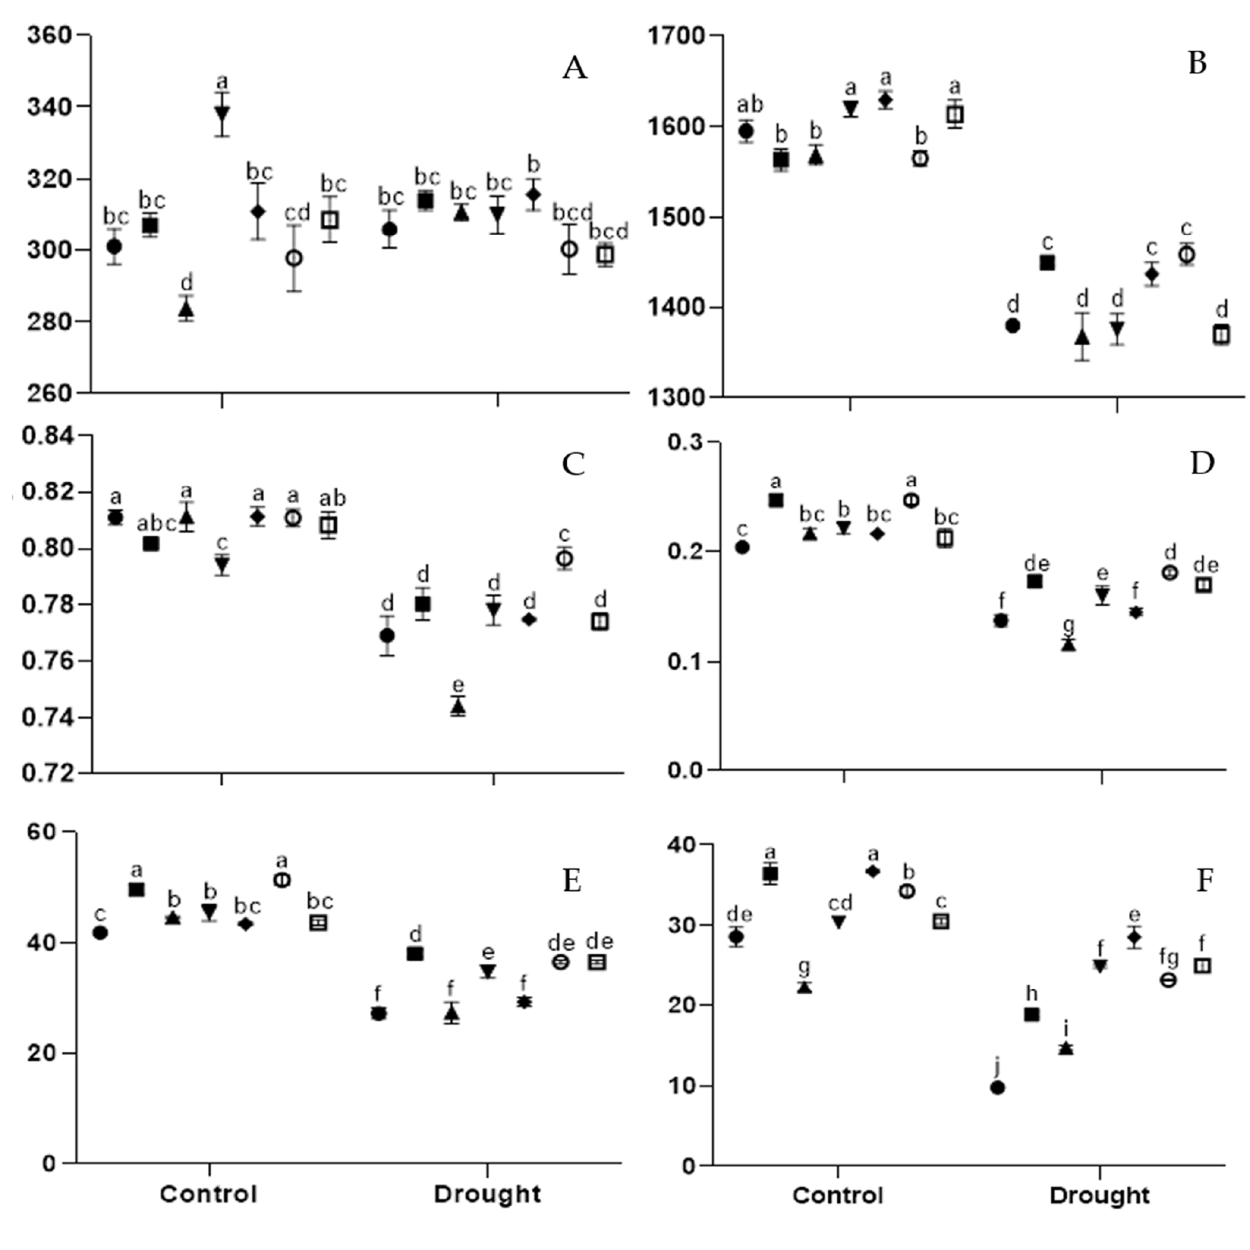
Figure 1. Parameters of chlorophyll fluorescence after dark adaptation: ( A )—minimum fluorescence (F0), ( B )—maximum fluorescence (Fm), ( C )—maximum PSII quantum yield in the dark-acclimated state (Fv/Fm) on the light: ( D )—PSII quantum yield in the light-acclimated state (Y (PSII)), ( E )— Electron Transport Rate (ETR) and ( F )—Chlorophyll Content Index (CCI) [non-nominated units]. The results were compiled based on 12 repetitions (4 independent biological repetitions yearly). Letters a–j indicate statistically different mean values ( α =